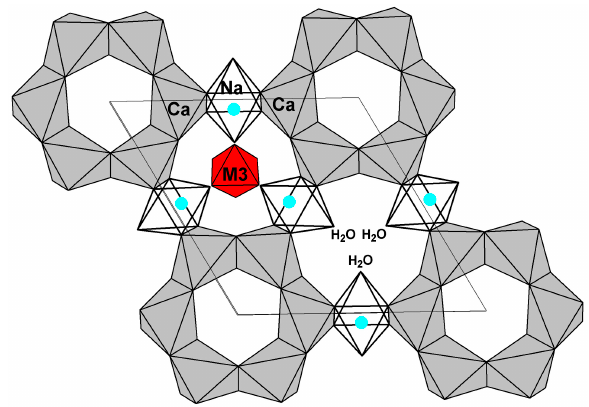
Figure 7. The local situation around M 2 Na-centered semioctahedra (square pyramids) in the structure of Sample 9 (Table 4) [2].